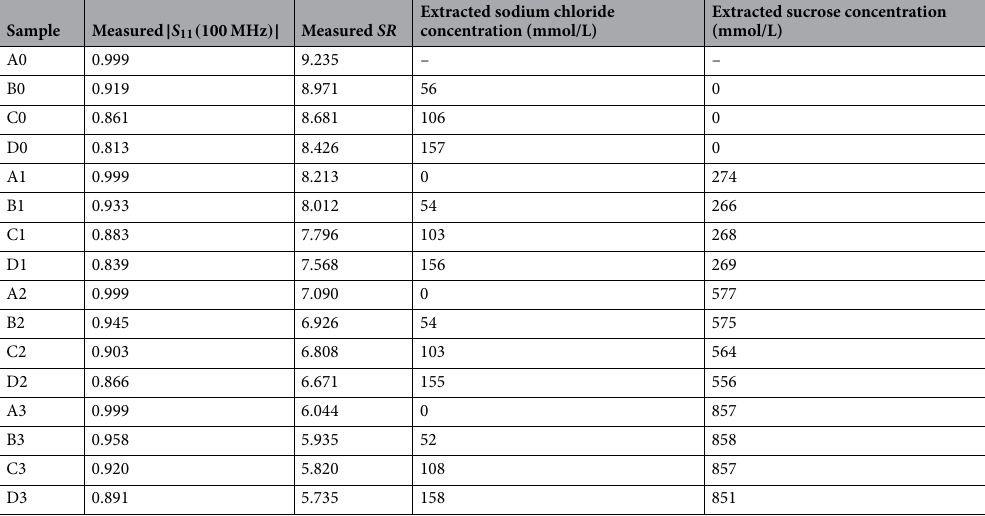
Table 5. Concentrations extracted from the measurements using Eqs.